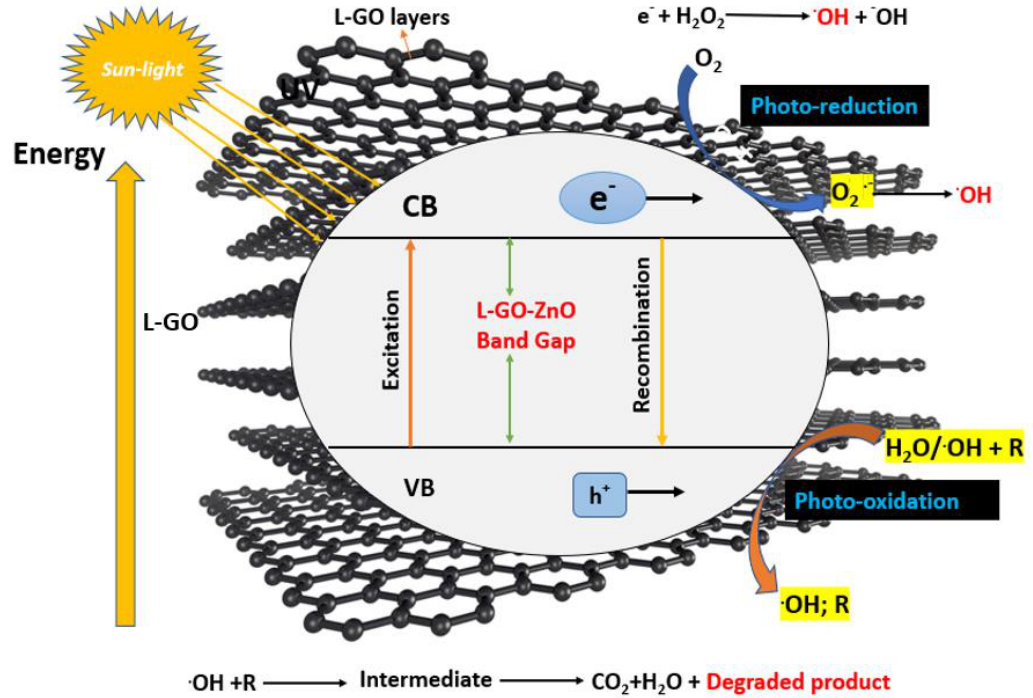
Figure 10. Mechanism of Photocatalytic degradation of dye using GO-ZnO (Adapted from refer- ence [3] with Springer